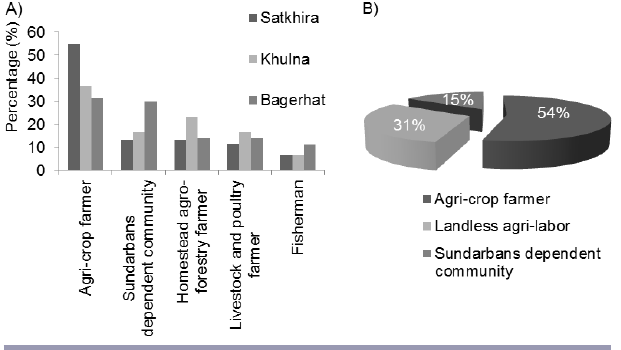
Fig. 5 . Coastal communities most affected by salinity